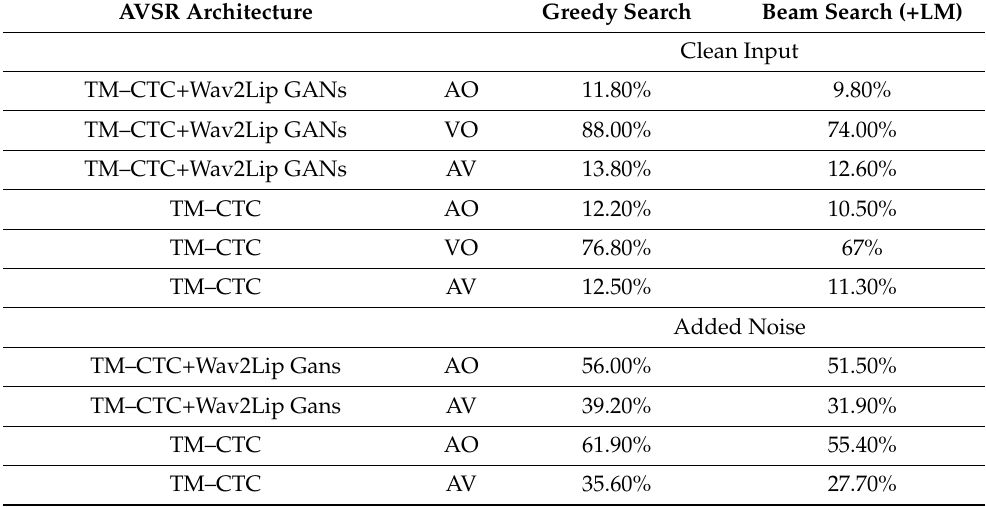
Table 3. Audio-only (AO), visual-only (VO) and audio-visual (AV) results of word-error rate (WER) tested on LRS3